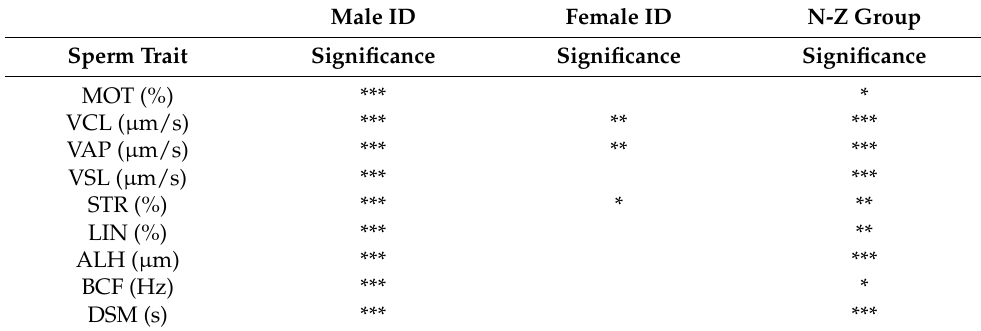
Table 1. Significant levels of the fixed effects of male ID, female ID and the effect of belonging of female to the native or zootechnical group (N-Z group) for all sperm traits.